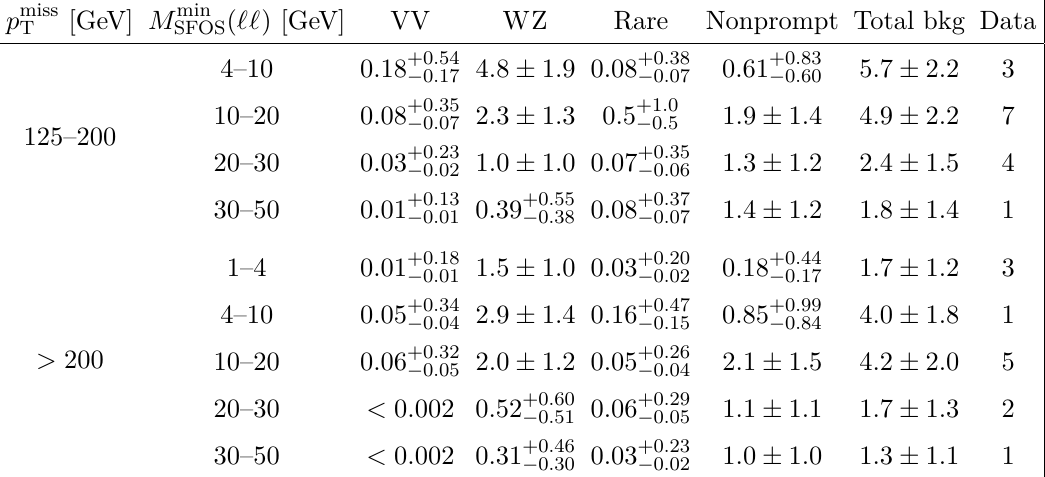
Table 5 . Observed and predicted yields as extracted from the maximum likelihood fit, in the 3 ‘ -Ewk SRs. Uncertainties include both the statistical and systematic components.